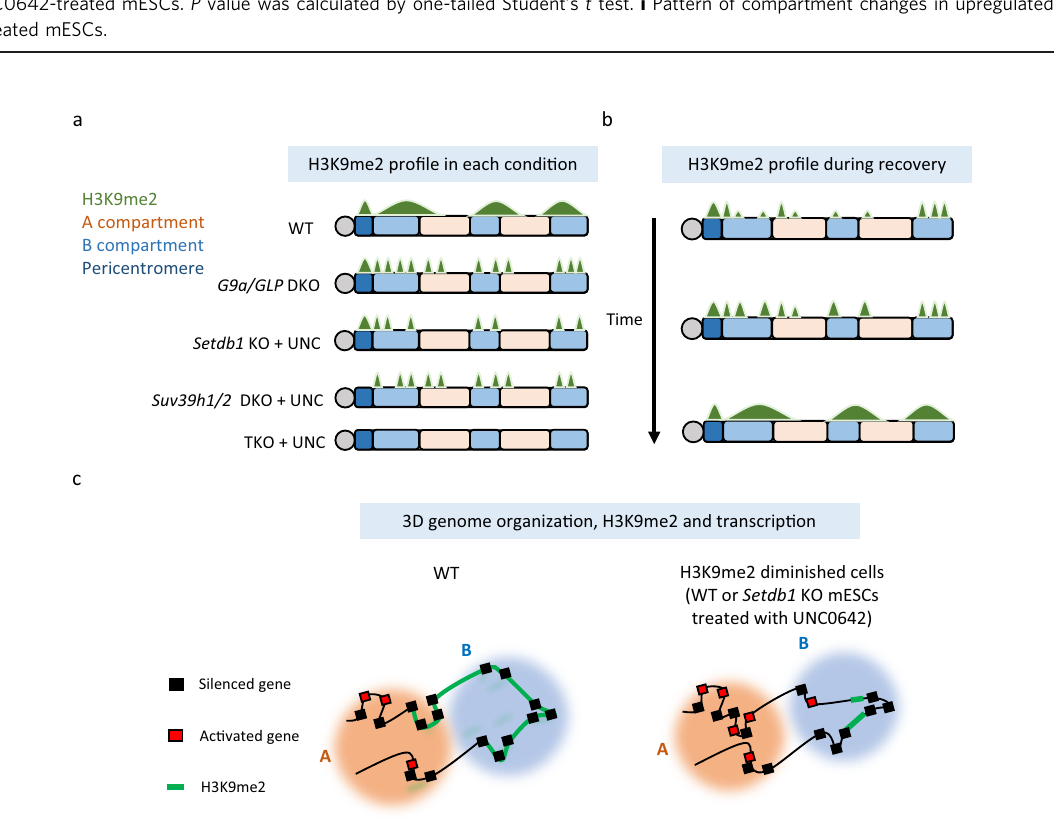
Fig. 5 Correlation of decreased H3K9me2 and movement toward more active compartment. a Representative view of compartment score in each 100-kb bin in mESCs. The regions colored by red and blue represent the A and B compartments, respectively. b Compartment change in each condition. More than 94% of compartments are maintained in all conditions. c Violin plots showing differences in H3K9me2 RPKM in each 100-kb bin classi fi ed by a degree of compartment score changes in UNC0642-treated mESCs. P value was calculated by Tukey ’ s test. Statistics comparison was only shown between the bins with ≧ 0.01 (0.01~) difference in compartment score and others. d Violin plots showing differences in H3K9me2 domain fraction in each 100-kb bin